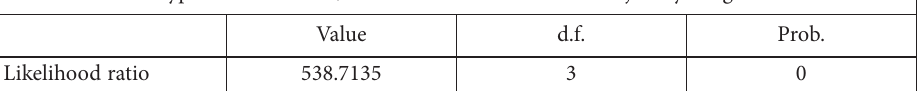
Table 11. Summary of the Redundant Variables Likelihood Ratio test Null hypothesis: ln RMU, ln R&DEXP and ln GMW are jointly